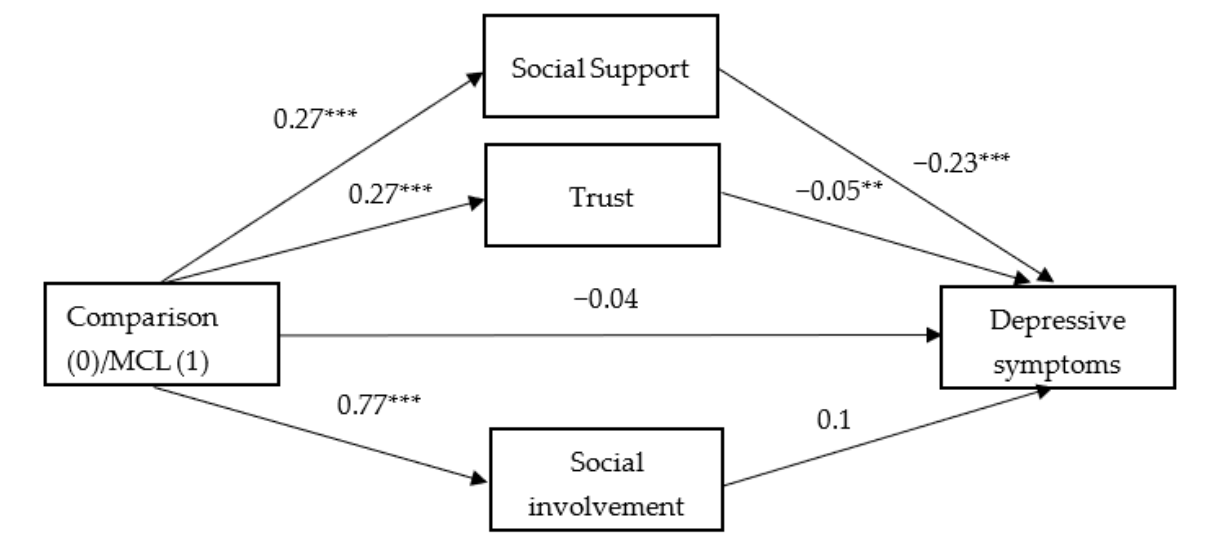
Figure 4. The mediation effect of social capital components on the link between participation in the Mamanet Cachibol League and depressive symptoms (unstandardized coefficients). ** p < 0.01; *** p < 0.001